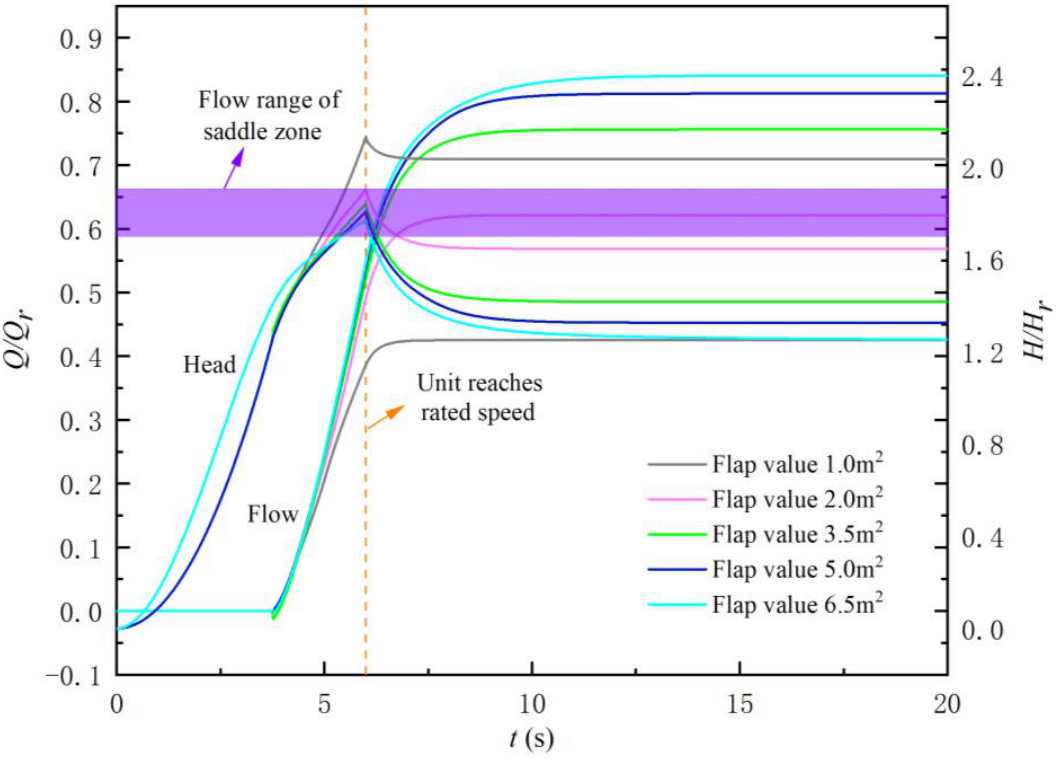
Figure 11. Variation pattern of the flow and head of LAPS equipped with FLVA under gate refusal working conditions.